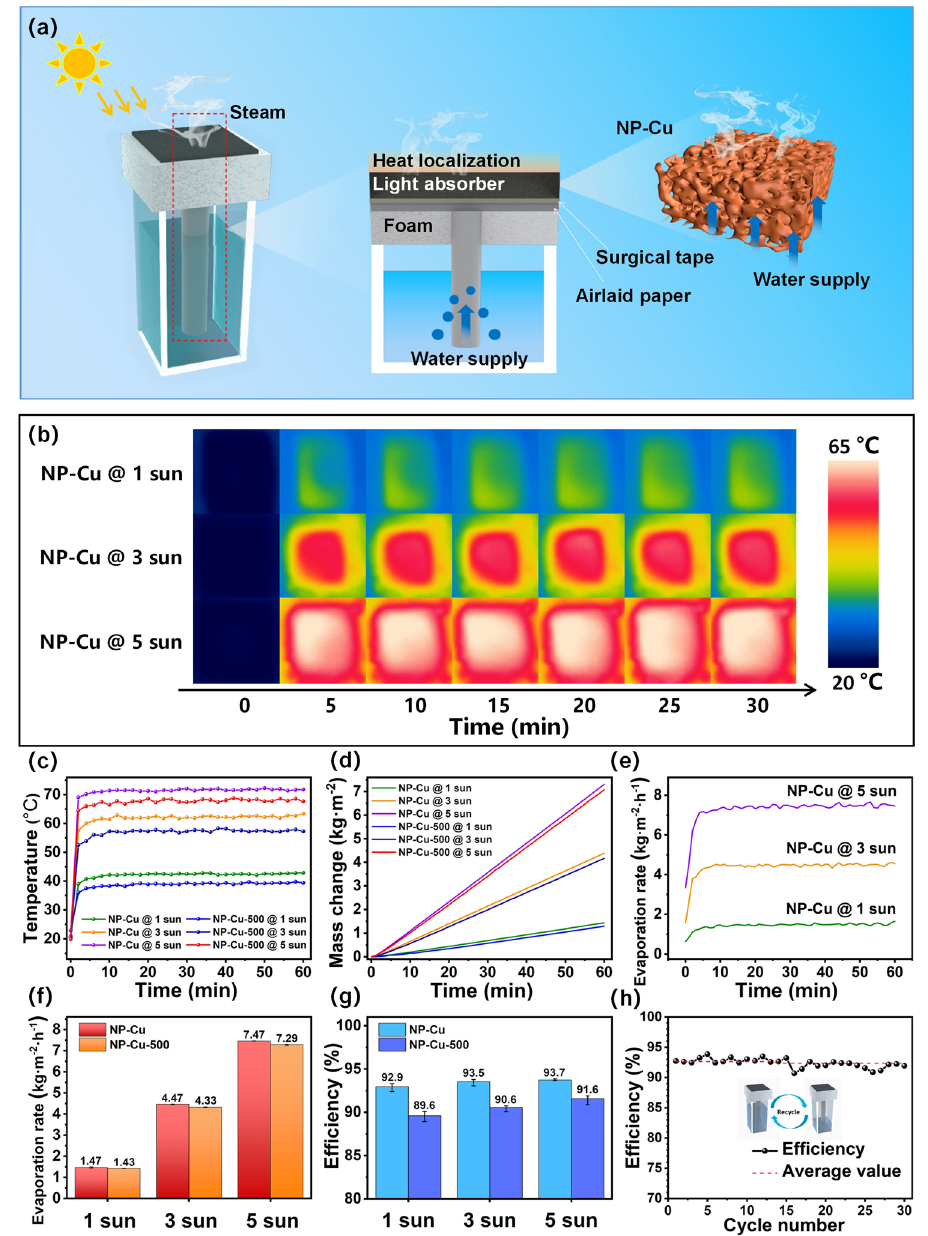
Fig. 5 a Schematic illustration of water evaporation process and mechanism. b Infrared images, c surface temperature changes, d mass changes, e evaporation rate with time, f evaporation rate and g evaporation efficiency of the NP-Cu and NP-Cu-500 films under different illuminations. h Cycling test of the NP-Cu film under 1 sun